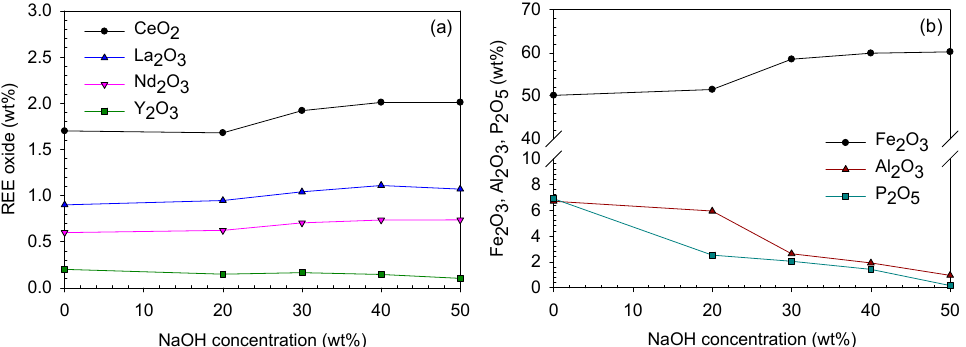
Figure 12. Oxide contents (wt%) of ( a ) REE and ( b ) Fe, Al and P of the digested product at different digesting NaOH concentrations .